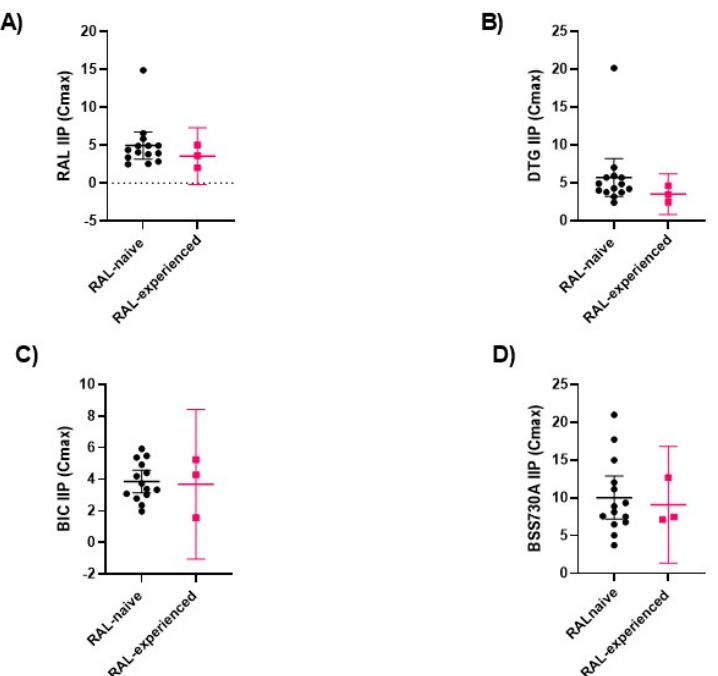
Figure 5. Comparison of IIP values of RAL ( A ), DTG ( B ), BIC ( C ), and BSS-730A ( D ) at Cmax for isolates from RAL-naïve and RAL-experienced patients. The Mann–Whitney test was used. Lines indicate mean values with 95% CI. Only p -values < 0.05 are shown.